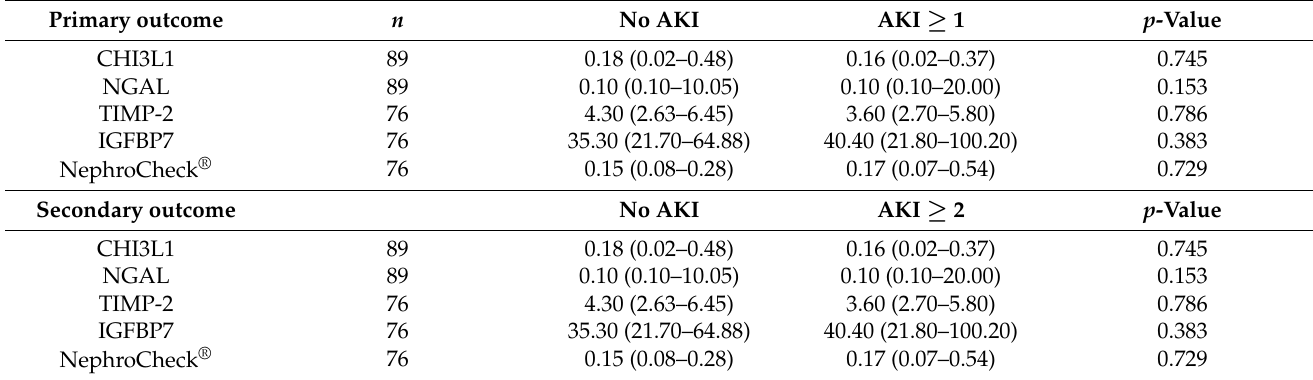
Table 3. Acute kidney stress biomarkers in pediatric patients with and without acute kidney injury.